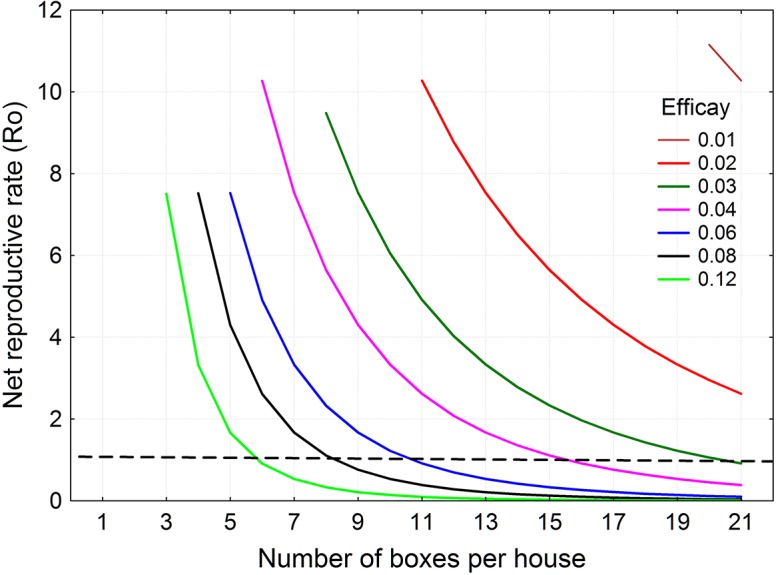
Performance of the fungal pathogen on the triatomine population dynamics based on the net population reproductive rate (R
0), as a function of the box Efficacy factor and the number of boxes/house.The black hatched horizontal line indicates the value of R
0 = 1, above which the triatomine population always increases; below that line the triatomine population always decreases.